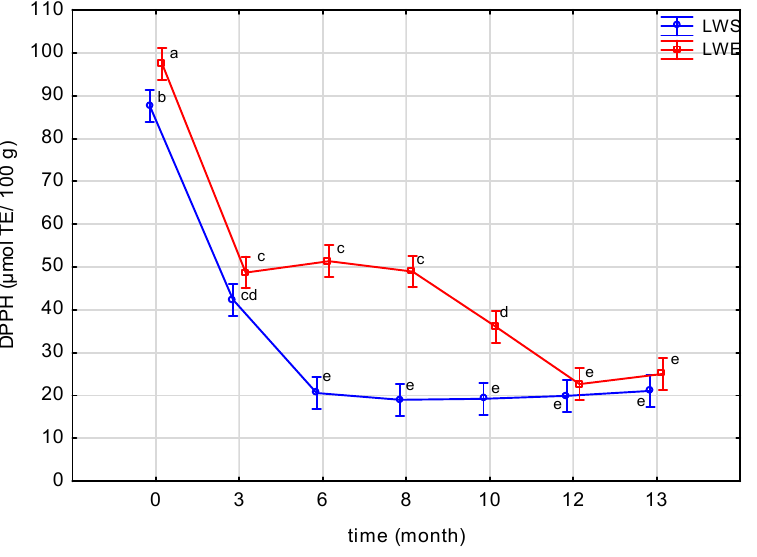
Figure 4. The antioxidant activity of the samples: standard wafers (LWS) and wafers with extract (LWE), measured as DPPH radical scavenging during 13 months of storage. Vertical bars indicate 0.95 confidence intervals, and the same letters indicate a lack of significant differences between data ( α = 0.05) .